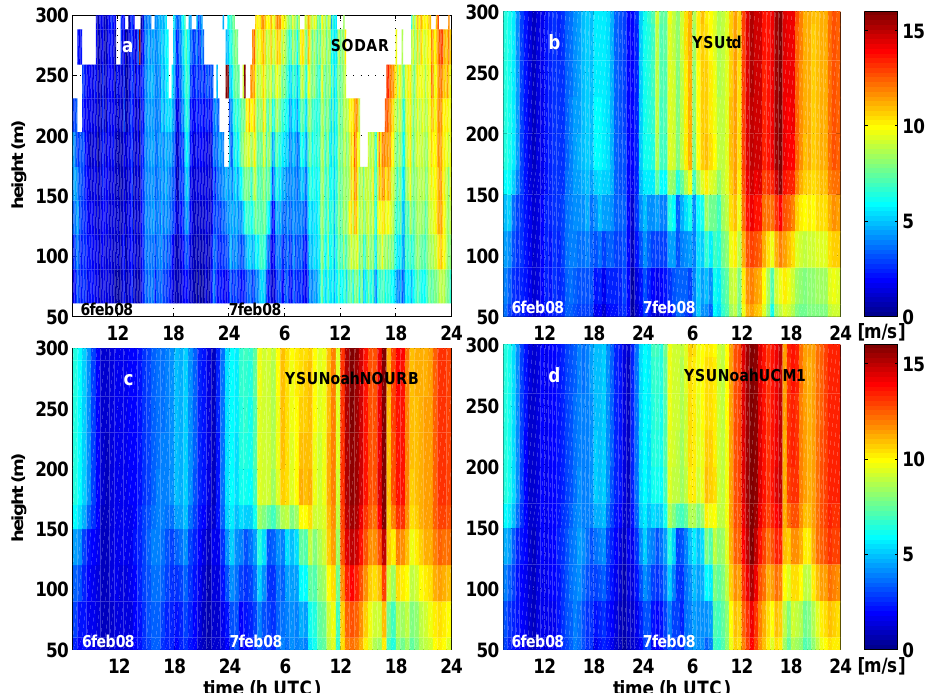
Fig. 8. Time series of the horizontal wind speed vertical profile on 6–7 February 2008 for (a) sodar measurements, (b) YSUtd, (c) YSUNoah- NOURB, (d) YSUNoahUCM1. Time is on the x axis and height on the ordinate